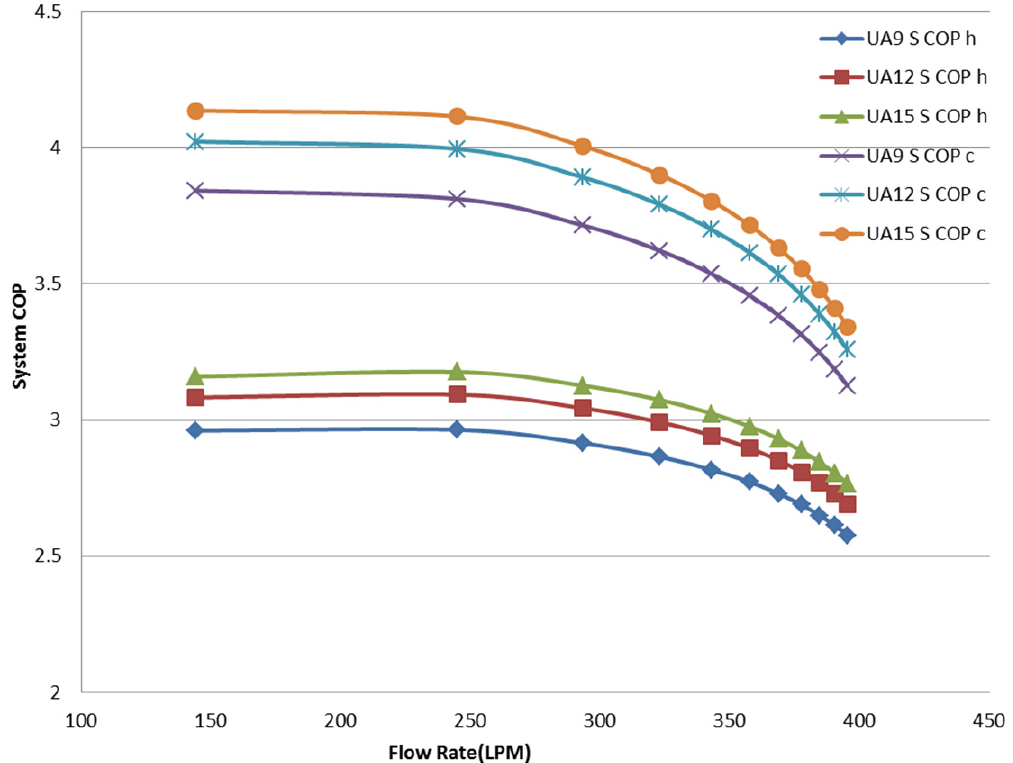
Figure 9. System cooling and heating COP variation to heat exchanger UA values.